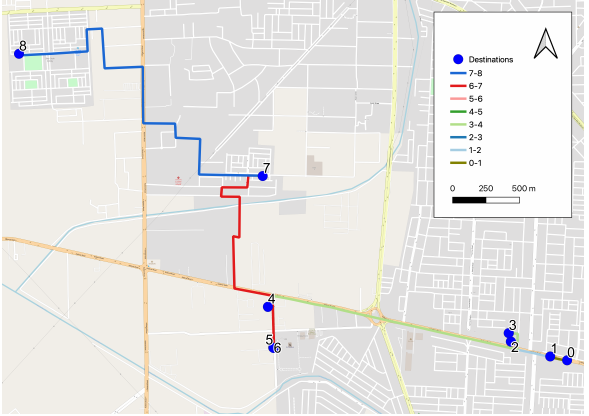
Figure 7. Expected value of the time to find an address for each delivery due to the ambiguous unstructured address against the free flow